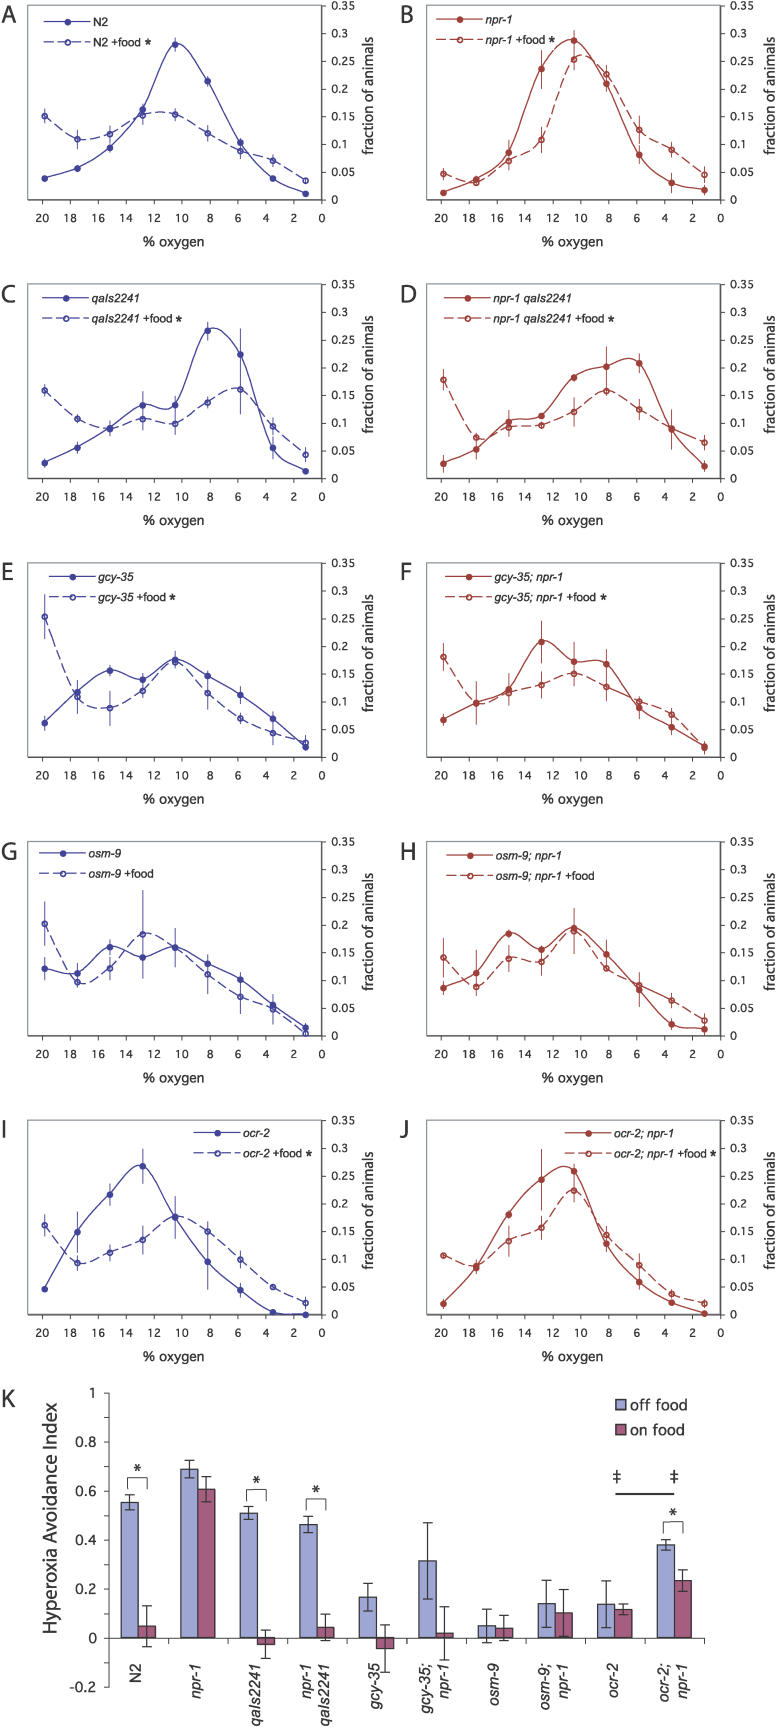
sGC and ocr-2 TRPV Mutations Restore Food Regulation of Hyperoxia Avoidance to npr-1
(A–J) In all panels, dotted lines indicate aerotaxis in the presence of a small amount of bacterial food. (A) Aerotaxis of wild-type N2 animals. (B) Aerotaxis of npr-1 mutants. (C) Aerotaxis of qaIs2241 strain (URX, AQR, PQR killed). (D) Aerotaxis of npr-1 qaIs2241 strain. (E) Aerotaxis of gcy-35 mutants. (F) Aerotaxis of gcy-35; npr-1 double mutants. (G) Aerotaxis of osm-9 mutants. (H) Aerotaxis of osm-9; npr-1 double mutants. (I) Aerotaxis of ocr-2 mutants. (J) Aerotaxis of ocr-2; npr-1 double mutants. For (A–J), asterisks denote distributions different by chi-square analysis at p < 0.01 from the same genotype without food. n ≥ 3 assays per genotype and condition, 80–100 animals/assay. Error bars denote SEM. (K) Hyperoxia avoidance index as defined in Figure 1. Asterisks denote values significantly different from the same genotype without food at p < 0.05 by t test. Error bars denote SEM. Double crosses indicate that ocr-2 mutants are significantly regulated by food using chi-square analysis of the entire distribution (p < 0.01), and that ocr-2; npr-1 on food is significantly different from ocr-2; npr-1 off food and npr-1 on food (p < 0.01 by chi-square analysis) and not significantly different from ocr-2 mutants on food.